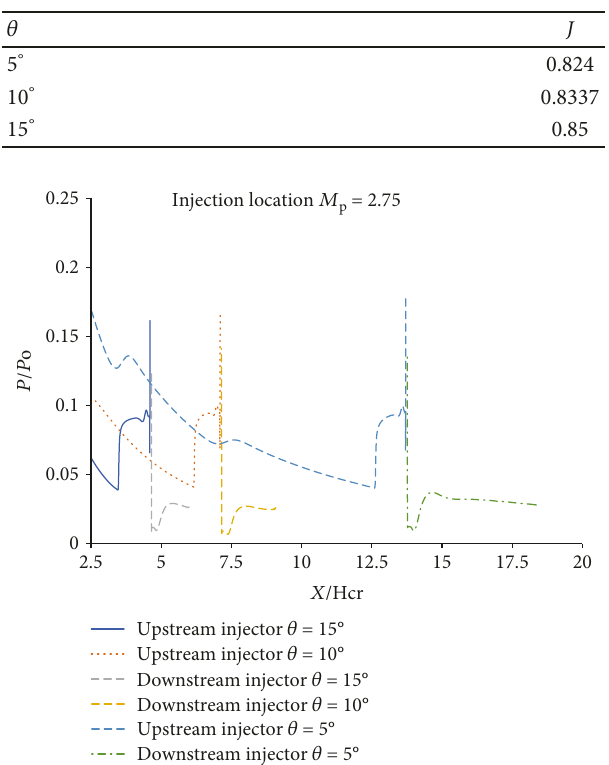
Table 9: SITVC performance parameters with respect to the injection angle at M = 2 75 . p